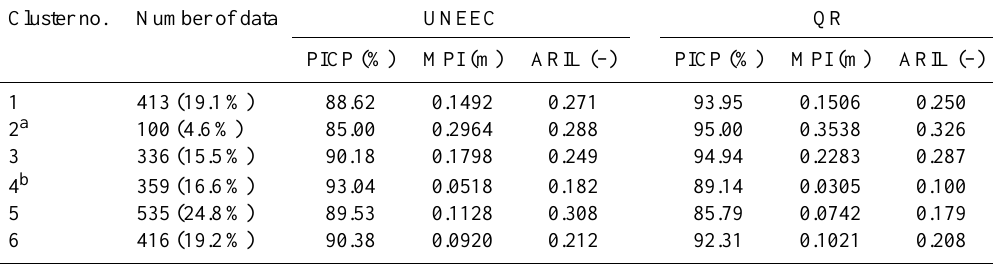
Table 5. PICP, MPI, and ARIL values for each cluster (training, 90% confidence level, Llanyblodwel, lead time 6h): UNEEC vs. QR. Cluster